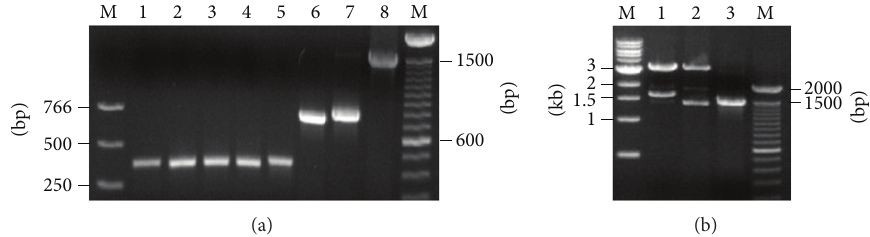
Figure 1: Construction of expression vector. (a) PCR products from three-round amplification. M, DNA marker; lane 1, GAPDH as internal control; lane 2, V H ; lane 3, V L ; lane 4, C H 1; lane 5, C L ; lane 6, heavy chain Fd; lane 7, light chain; lane 8, Fab. (b) Recombinant vector pComb3X/LF8-Fab recut by Sfi I. M, DNA marker; lane 1, pComb3XSS cut by Sfi I; lane 2, pComb3X/LF8-Fab recut by Sfi I; lane 3, PCR product of Fab.